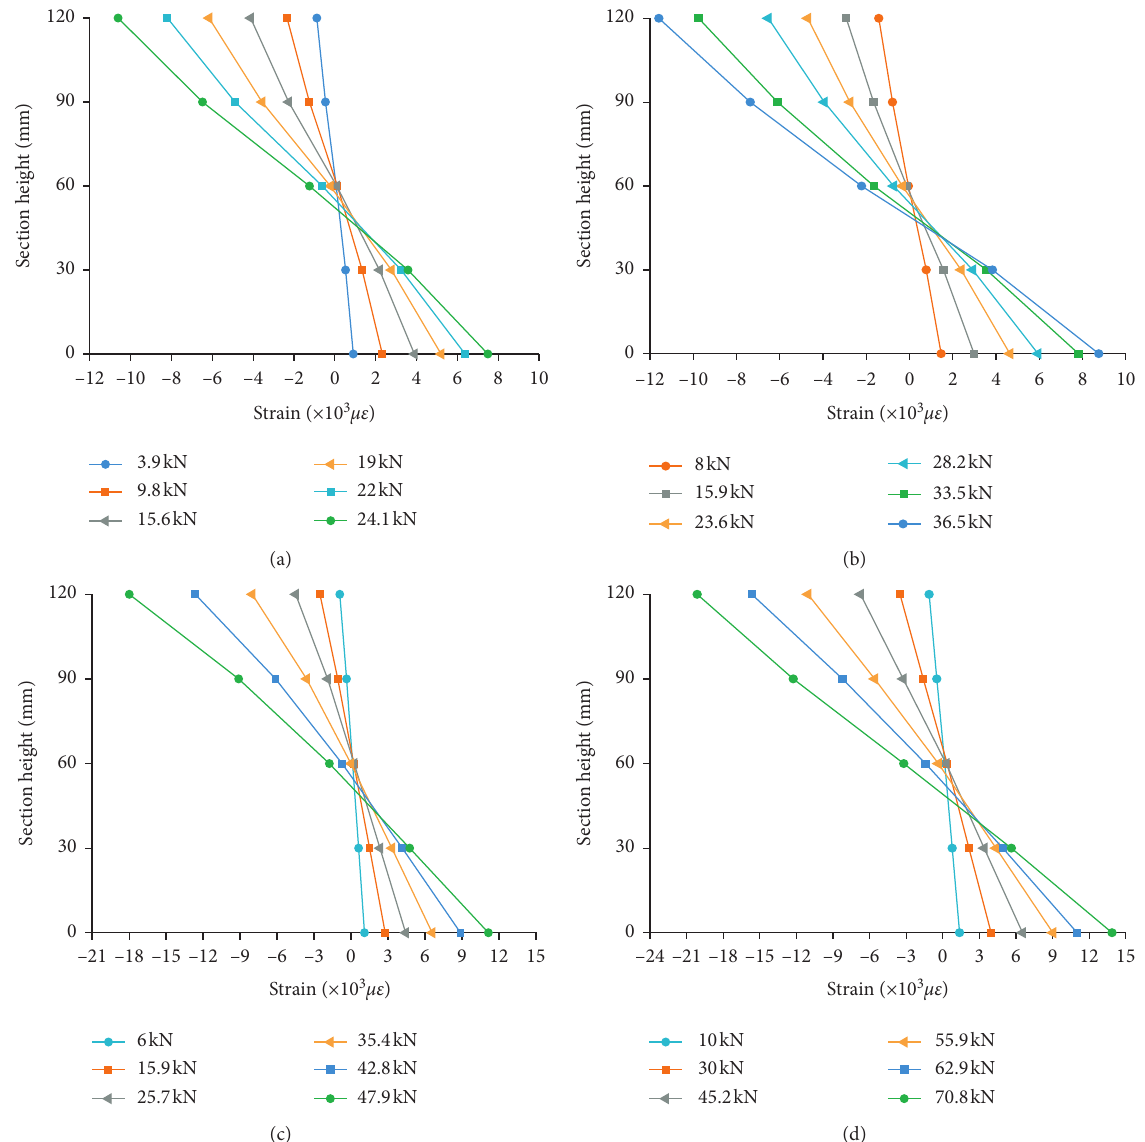
Figure 6: Strain distribution along the height of section at the midspan of typical specimens. (a) Specimen B2. (b) Specimen C2. (c) Specimen D2. (d) Specimen